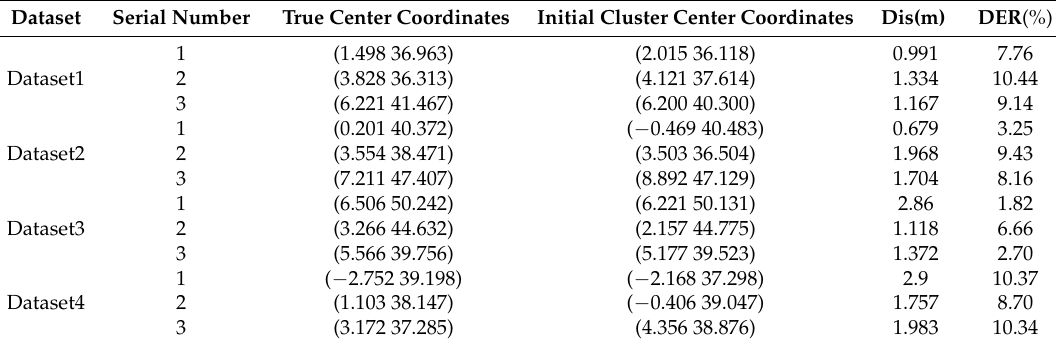
Table 1. Comparison of the results of the initial cluster center and the true center of the